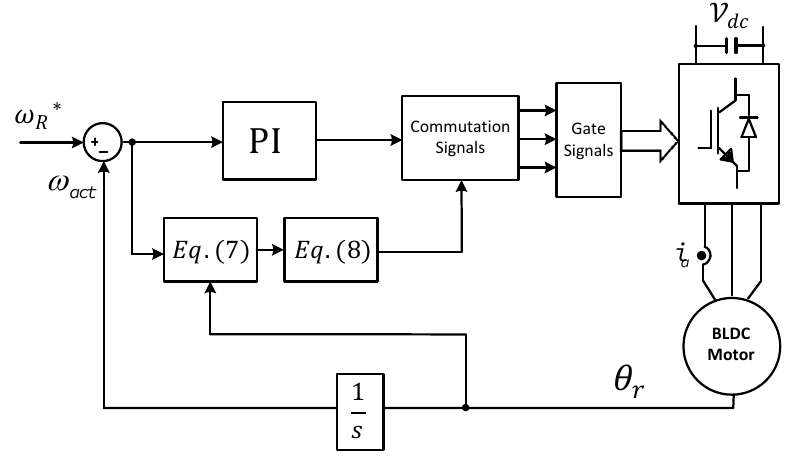
Figure 10. Experimental test-bed: inverter, DSP control unit and torque transducer.